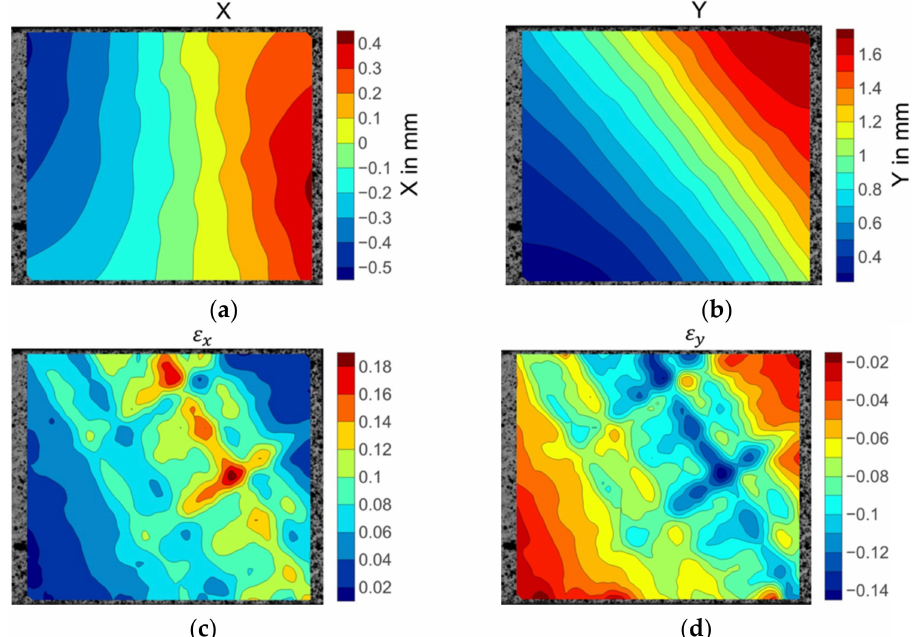
Figure 10. The displacement and strain field contour plots of the 30 ◦ off-axis specimen: ( a ) Displace- ment in the X direction; ( b ) displacement in the Y direction; ( c ) strain in the X direction; ( d ) strain in the Y